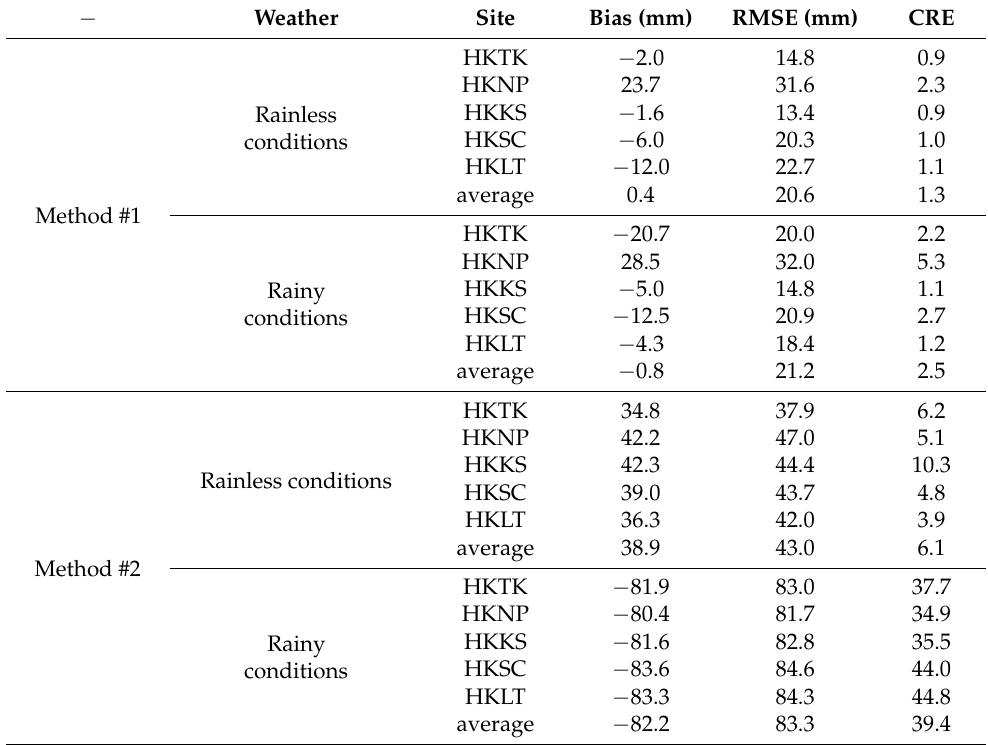
Table 4. Statistical results of the external accuracy verification for the two methods in rainless and rainy conditions.